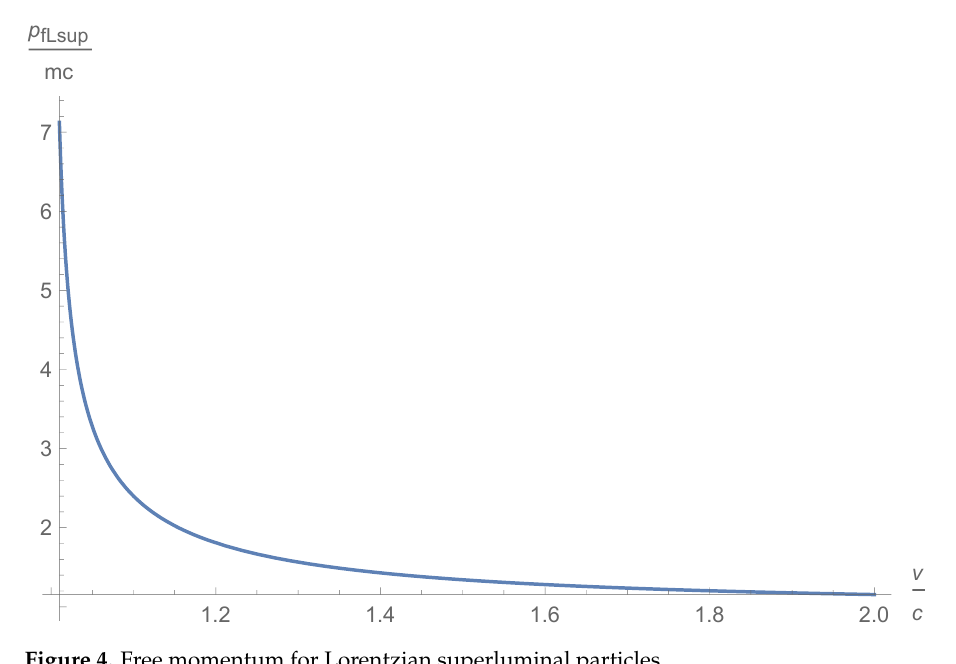
Figure 4. Free momentum for Lorentzian superluminal particles.